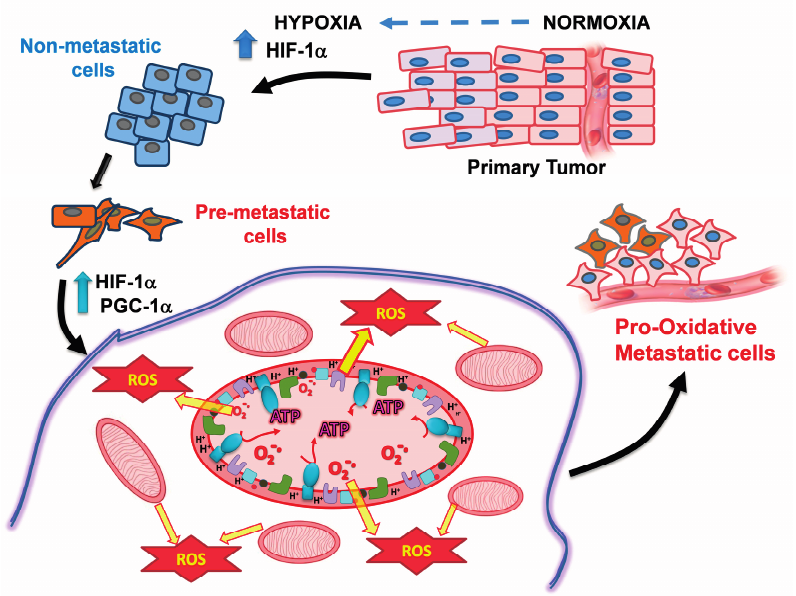
Figure 1. PGC-1 α  mediated OxPhos activation and ROS generation promotes the metastatic cancer cell phenotype. Hypoxic non-metastatic cancer cells maintain a diminished level of mitochondrial metabolism. However, hypoxia causes PGC-1 α  and HIF-1 α , HIF-2 α  overexpression which induces in pro-metastatic cells the generation of a higher number of mitochondria, increased OxPhos flux for ATP synthesis and increased ROS levels, all leading to the epithelial-mesenchymal transition and formation of highly metastatic cells. Abbreviations: OxPhos, oxidative phosphorylation; ROS, reactive oxygen species; HIF-1  , Hypoxia-Inducible Factor 1-alpha; PGC-1  , Peroxisome Proliferator- activated Receptor Gamma Co-activator